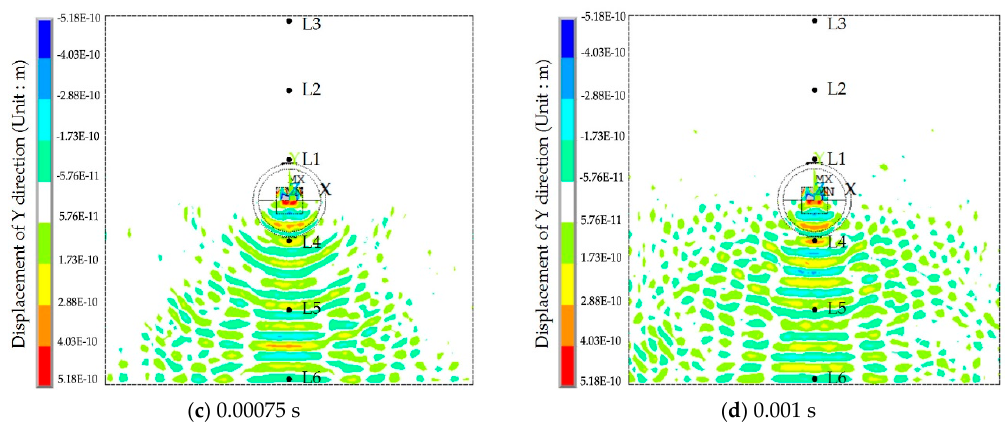
Figure 7. The displacement contour at the 50% grouting level.